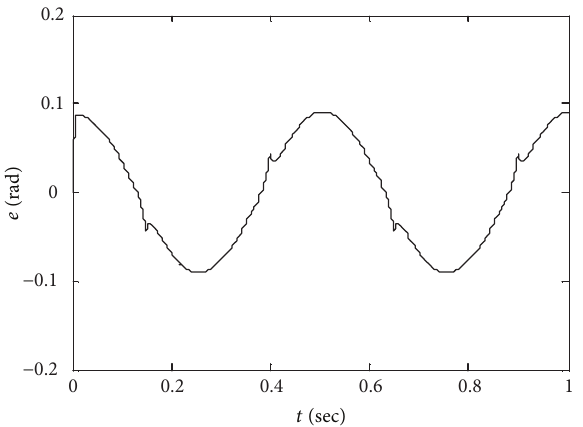
Figure 9: The tracking error under PID-controller.